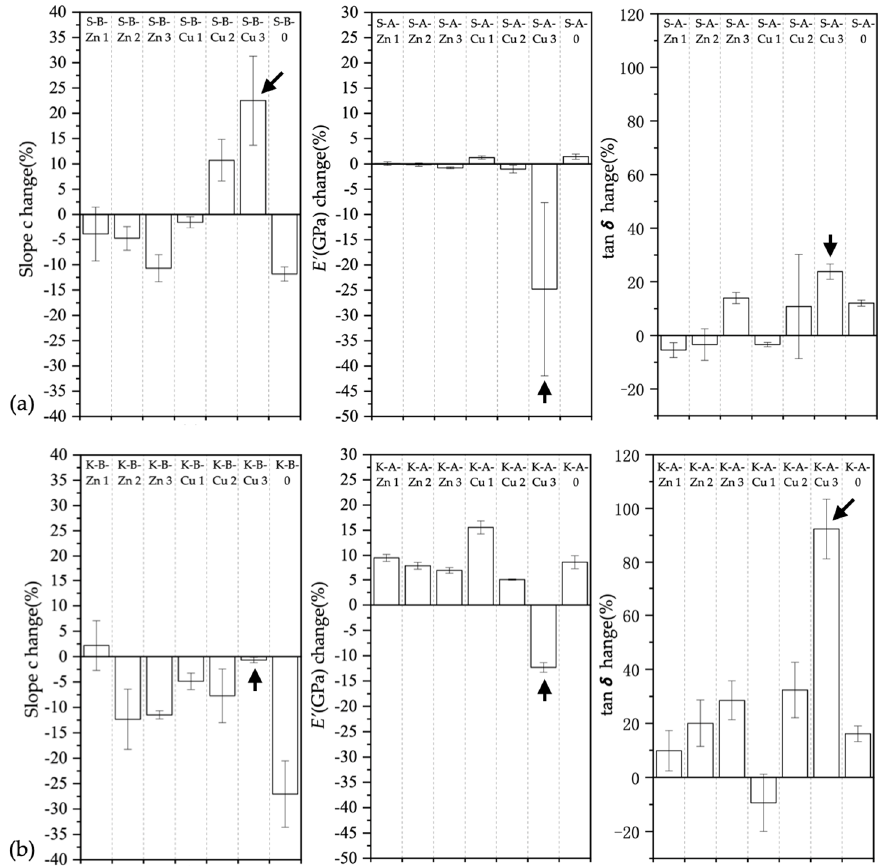
Figure 10. The average changes in the slope of the force–displacement diagram, E’ , and tan δ obtained by a flexural vibration test after 120 days of exposure with respect to the unexposed samples: ( a ) Sugi groups; ( b ) Keyaki groups ( n = 3). The high Cu(II)-containing S/K-B-Cu 3 showed significantly distinct performances (pointed by black arrows).